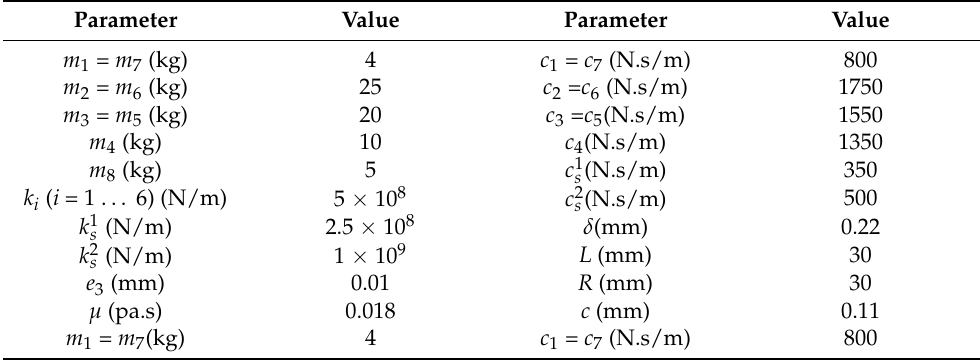
Table 1. Parameters of the rotor-bearing